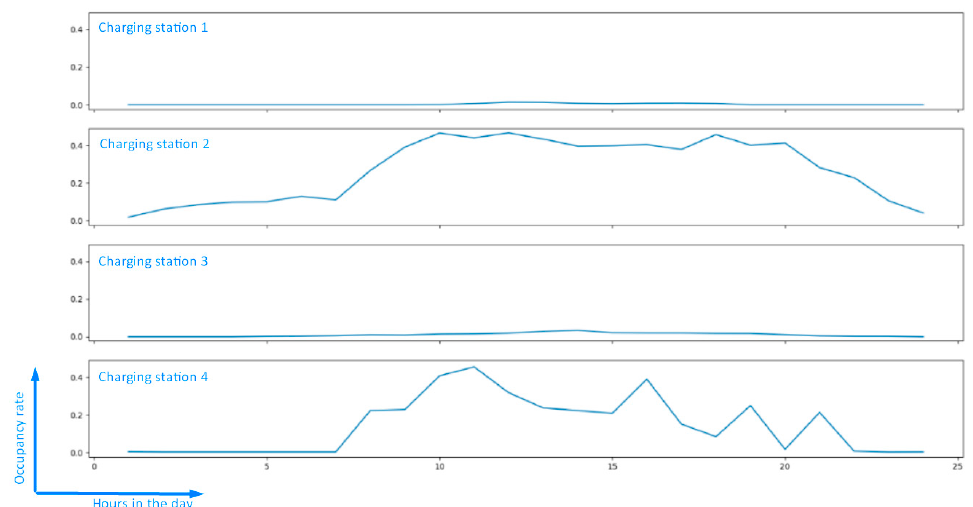
Figure 5. Examples of the availability of charging stations throughout the day.